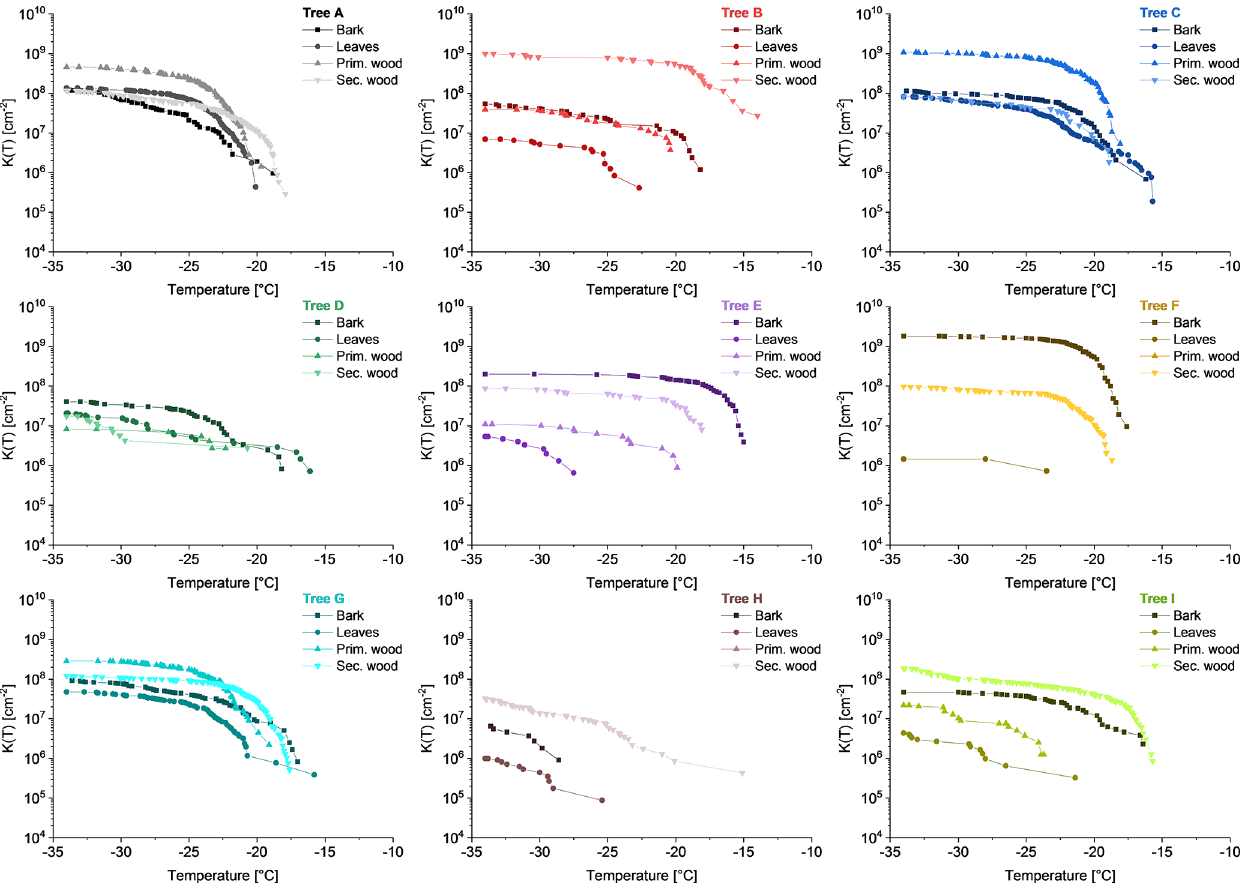
Figure 5. Cumulative nucleus spectra K(T ) of aqueous extracted bark, branch wood and leaf surfaces. Samples originate from nine different birches (named Tree A to I) in Tyrol, Austria. Rectangles show bark samples, dots represent leaves, triangles with the cone end up illustrate primary wood and triangles with the cone end down secondary wood. Nearly all samples freeze heterogeneously. Two samples are not active, both of which are primary wood (Tree F and